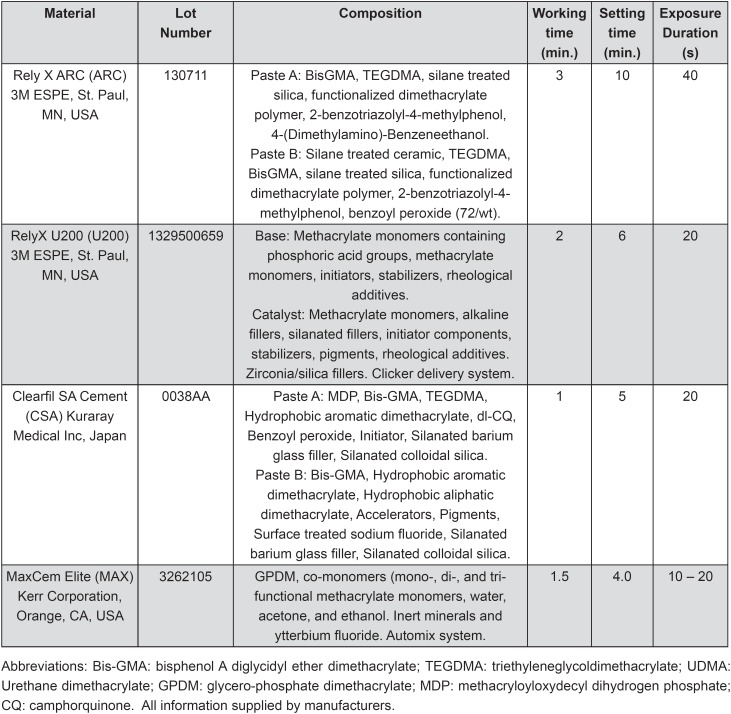
Composition, manufacturers, and batch numbers of the cements used